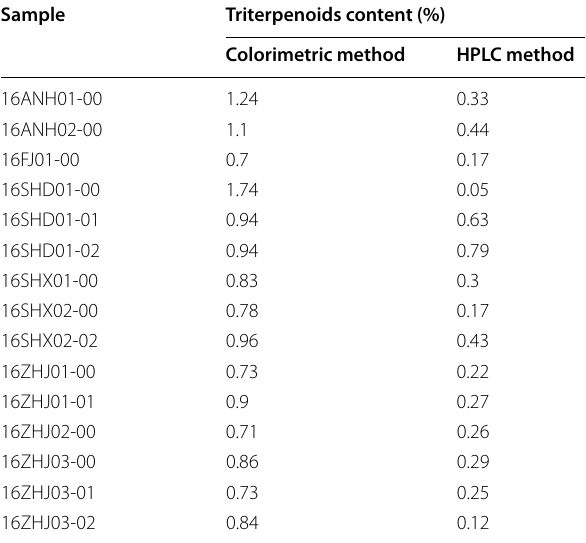
Table 4 The results of triterpenoids content by colorimetric and